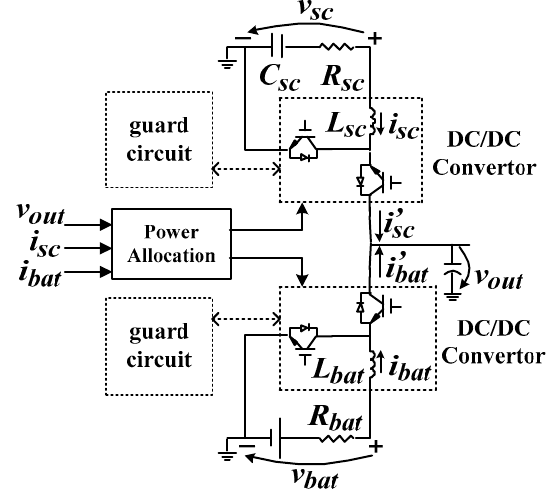
Figure 7. Conventional control structure.